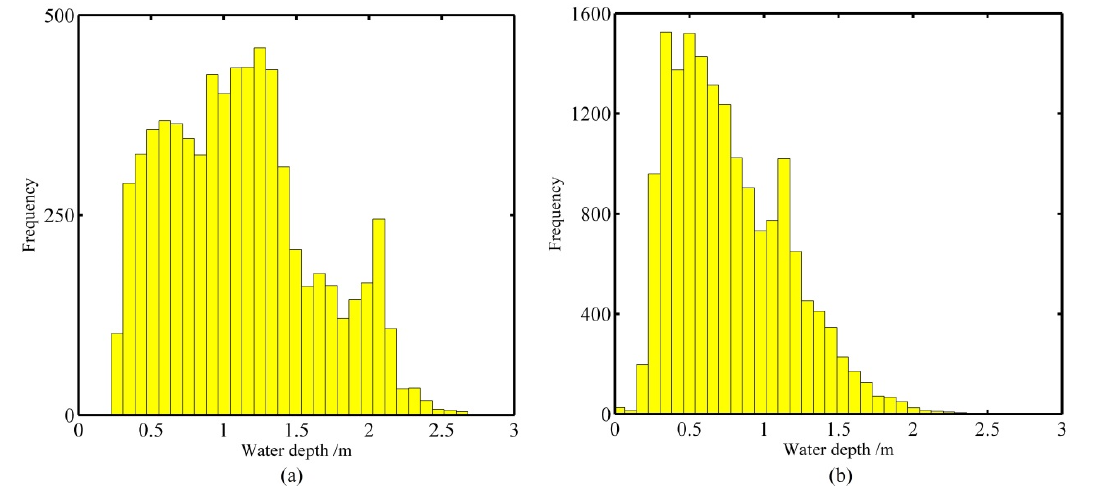
Figure 6. Field measured Acoustic Doppler Current Profiler (ADCP) water depth distribution for ( a ) Snake River (6968 measurements) and ( b ) Blue/Colorado River (16,681 measurements). Most water depths for the Snake River are less than 2 m while most water depths for the Blue/Colorado River are less than 1.5 m.